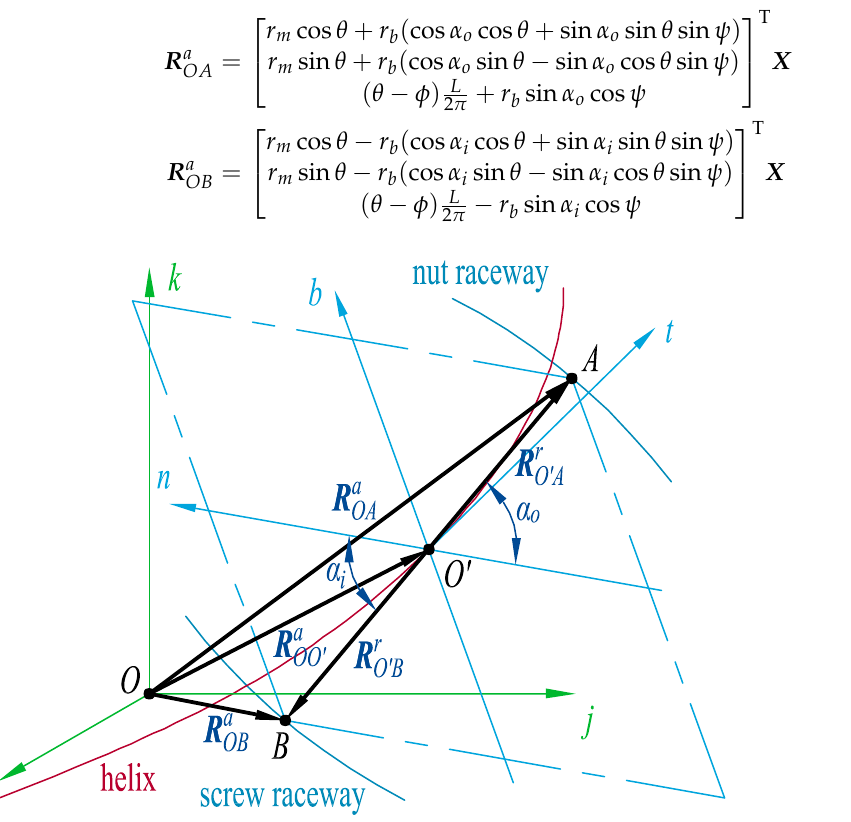
Figure 2. Position of contact